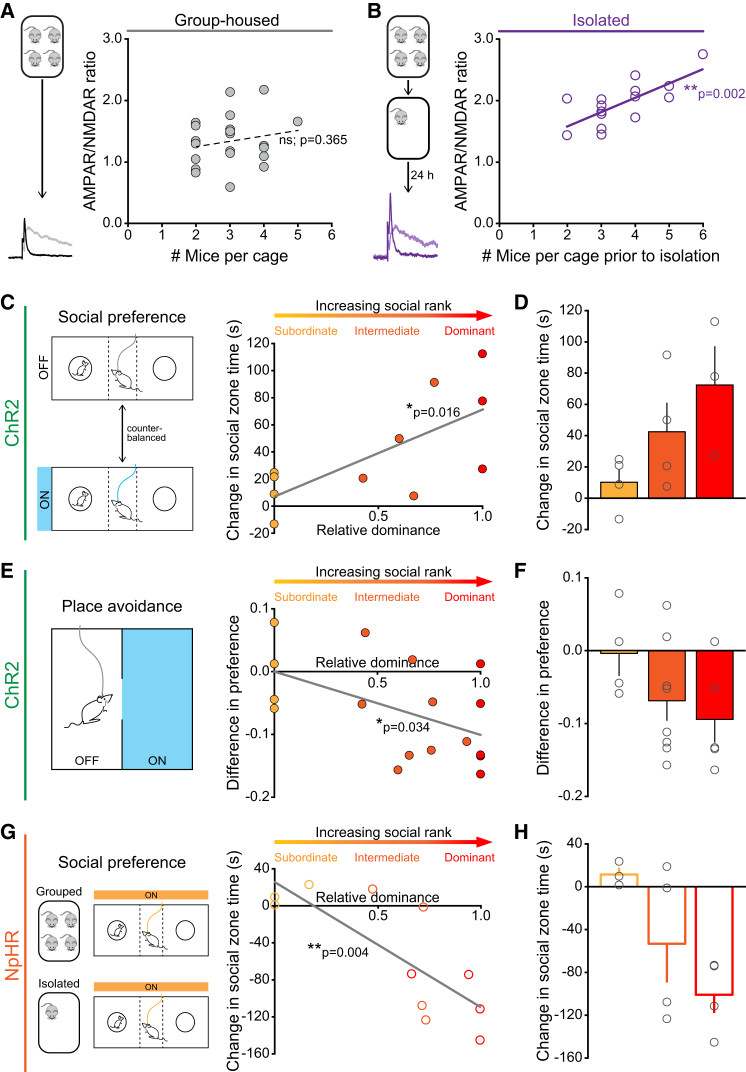
Prior Social Experience Predicts Magnitude of Social Isolation-Induced Synaptic Potentiation and Behavioral Response to Optogenetic Manipulation(A and B) Scatter plot of AMPAR/NMDAR ratios recorded in DRN DA neurons plotted against the number of mice per cage in group-housed mice, and (B) the number of mice previously housed per cage in socially isolated mice. No significant correlation was detected in group-housed mice (Pearson’s correlation: p = 0.3653, r2 = 0.0374, n = 24), but a significant positive correlation was found in socially isolated mice (Pearson’s correlation: ∗∗p = 0.0021, r2 = 0.5282; n = 15).(C) Relative social rank of TH::Cre mice was estimated with a score of 0 indicating the most subordinate and 1 the most dominant mouse in each cage. Relative dominance of ChR2-expressing mice plotted against the change in time spent in the social zone of the three-chamber apparatus (with blue light stimulation − without stimulation). There was a significant positive correlation between relative dominance and change in social zone time (Pearson’s correlation: ∗p = 0.0163, r2 = 0.4913; n = 11).(D) Mean (+ SEM) change in social-zone time for mice of each social rank.(E) Relative dominance of ChR2-expressing mice plotted against the difference in preference for the light-stimulation zone (proportion of time spent in the stimulation zone − proportion of time spent in the unstimulated zone) in the RTPA assay. There was a significant negative correlation between relative dominance and preference for the stimulation zone (Pearson’s correlation: ∗p = 0.0338, r2 = 0.2668, n = 17).(F) Mean (− SEM) difference in preference for stimulation zone for mice of each social rank.(G) Relative dominance of NpHR-expressing mice plotted against the change in social-zone time (isolated with yellow light – grouped with yellow light). There was a significant negative correlation between relative dominance and the change in social-zone time following isolation (Pearson’s correlation: ∗∗p = 0.0038, r2 = 0.6241, n = 11).(H) Mean (± SEM) change in social zone time for mice of each social rank.See also Figure S7.